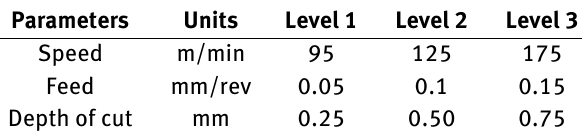
Table 3: Selection of machining parameters and their levels Parameters Units Level 1 Level 2 Level